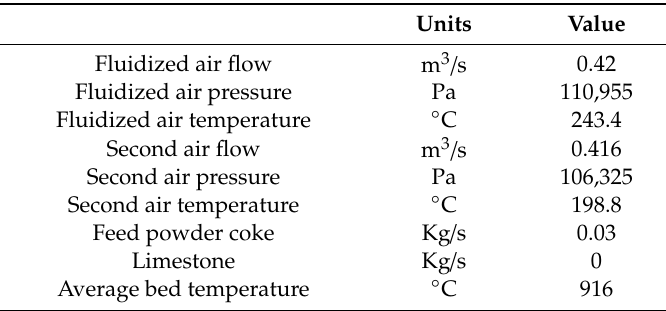
Table 3. Experimental and modeling conditions.